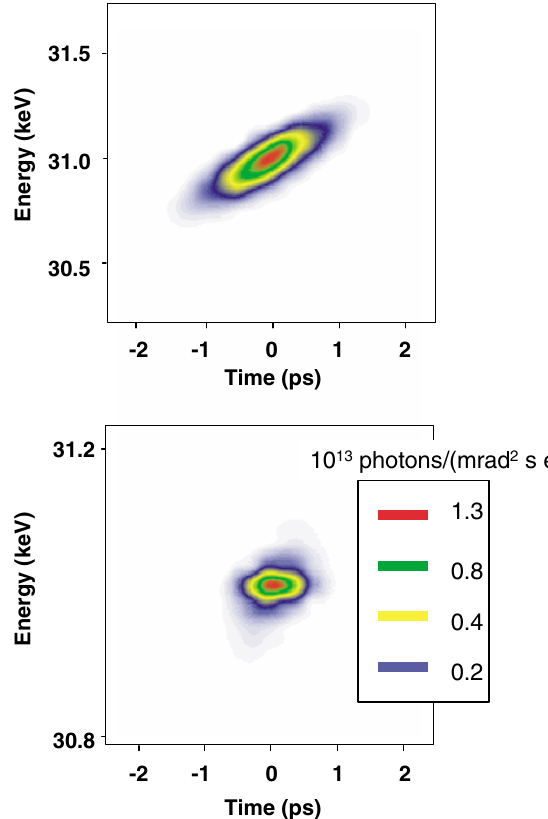
FIG. 16. (Color) Simulated on-axis x-ray spectrum for the chirped Thomson scattered x rays produced by colliding a chirped laser pulse side on with an unchirped electron bunch, before (top panel) and after (bottom panel) spectral